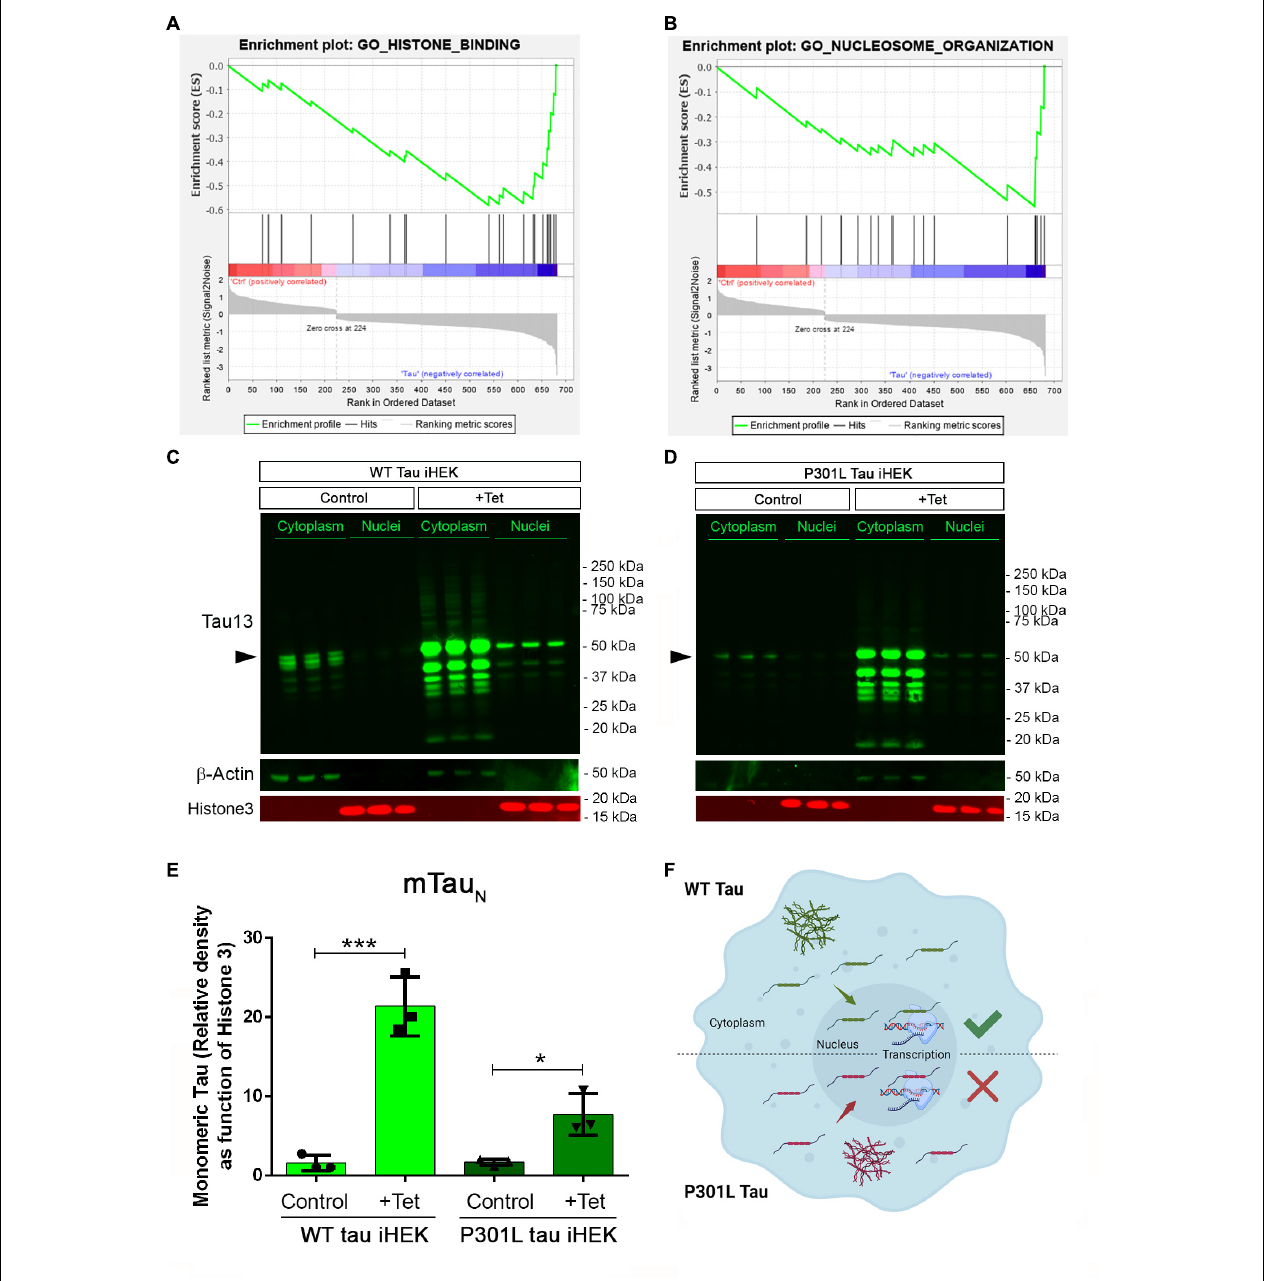
FIGURE 4 | Tau nuclear shuttling. (A) GSEA GO-Histone Binding heat map in WT tau. (B) GSEA GO-Nucleosome organization heat map in WT tau. (C) Immunoblot (IB) with Tau13 (1:1,000) and β -Actin (1:1,000) of cytoplasm and nuclear fraction from WT (left panel) and (D) P301L (right panel) tau induced with Tet. Monomeric tau is indicated by rightwards filled arrows (E) Relative density of nuclear monomeric tau (mTauN, normalized with Histone3). Unpaired t-test has been performed to compare column means [(–) WT tau vs. WT tau *** p = 0.0009, (–) P301l tau vs. P301L tau * p = 0.0169]. (F) Schematic model on tau nuclear import in the two iHEK cell